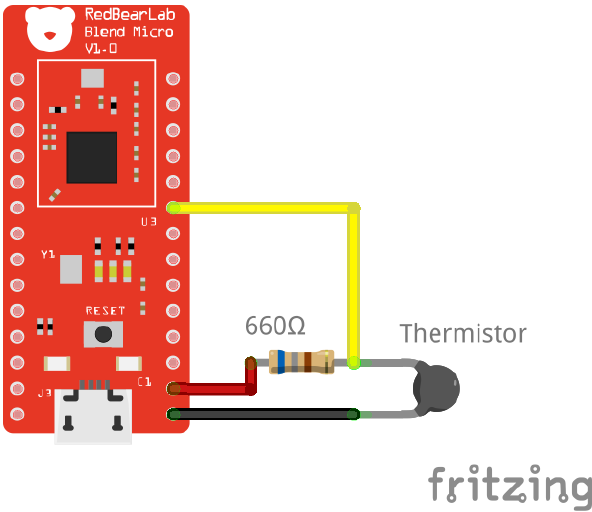
Figure 1. Schematic overview of the circuit used to read out the measurements from the